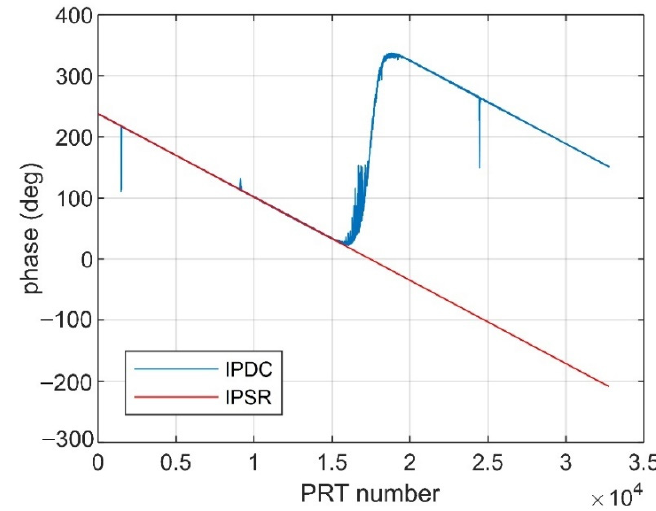
Figure 4. IPSRs and IPDCs along azimuth (10 dB JSR).